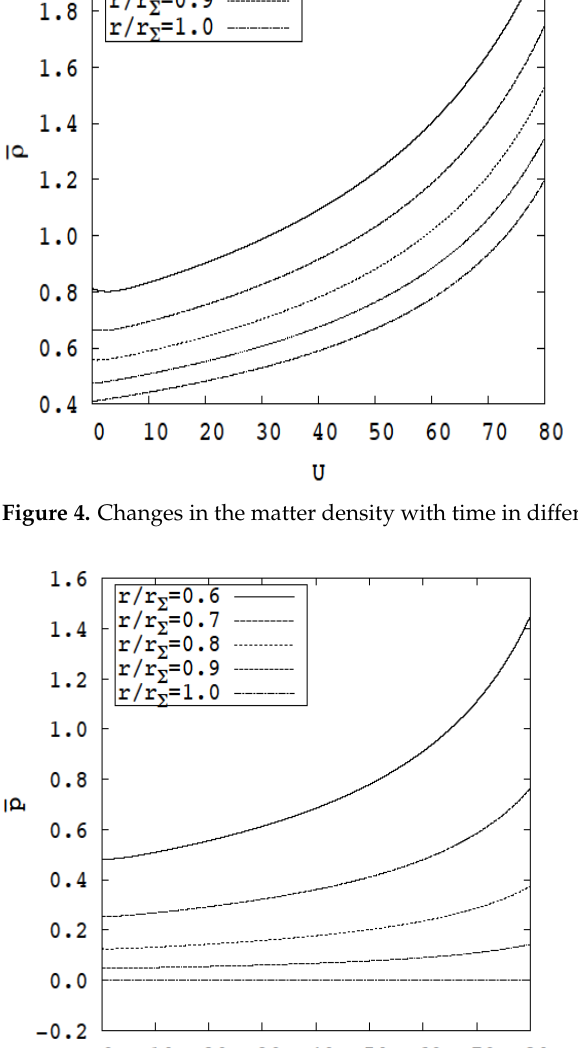
Figure 5. Evolution with time of the radial pressure (multiplied by 10 2 ).